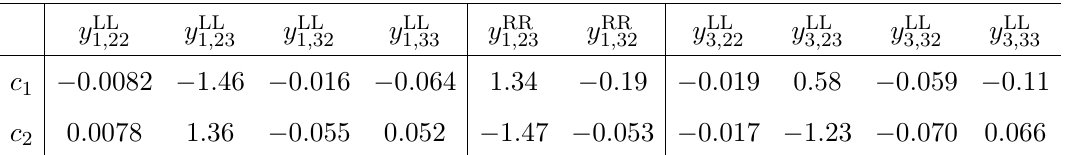
Table 3 . Non-zero Yukawa couplings for two benchmark points in a two-leptoquark scenario providing an explanation for the flavour anomalies [104]. Benchmarks include S 1 and S 3 leptoquarks (with m S = m S = 1 . 2 TeV). Points c 1 and c 2 correspond to the p 1 and p 2 benchmarks in the 1 3 notation of